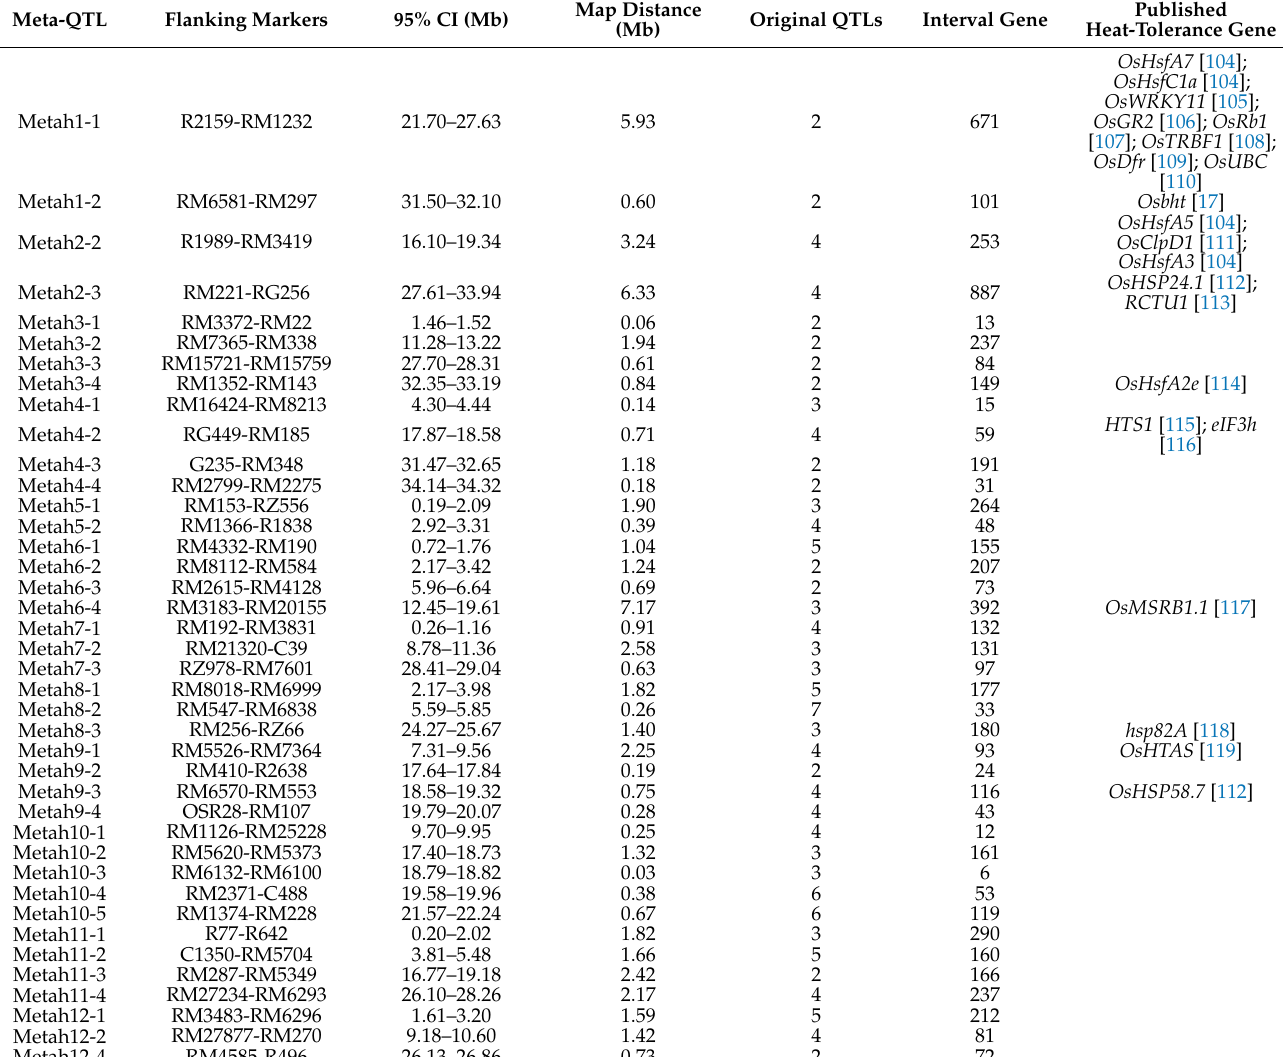
Table 2. 40 heat-tolerant meta-QTLs in